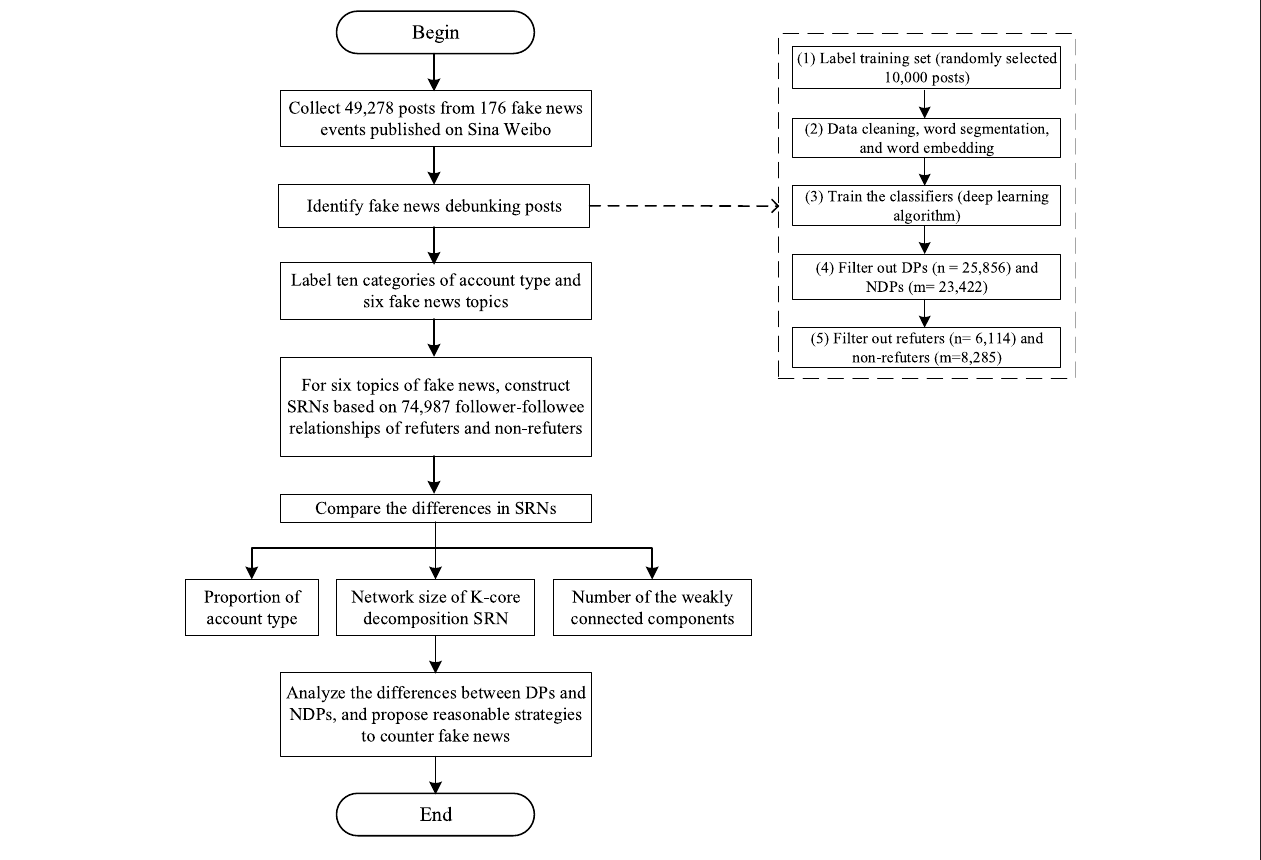
FIGURE 1 | Process for research procedures.